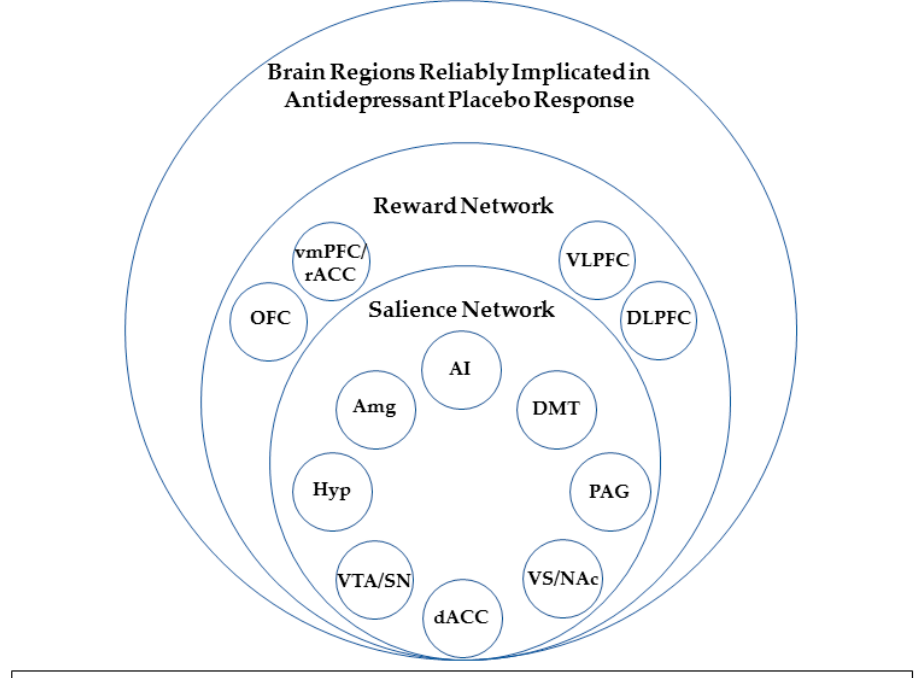
Figure 1. Brain regions reliably implicated in antidepressant placebo response and their associated